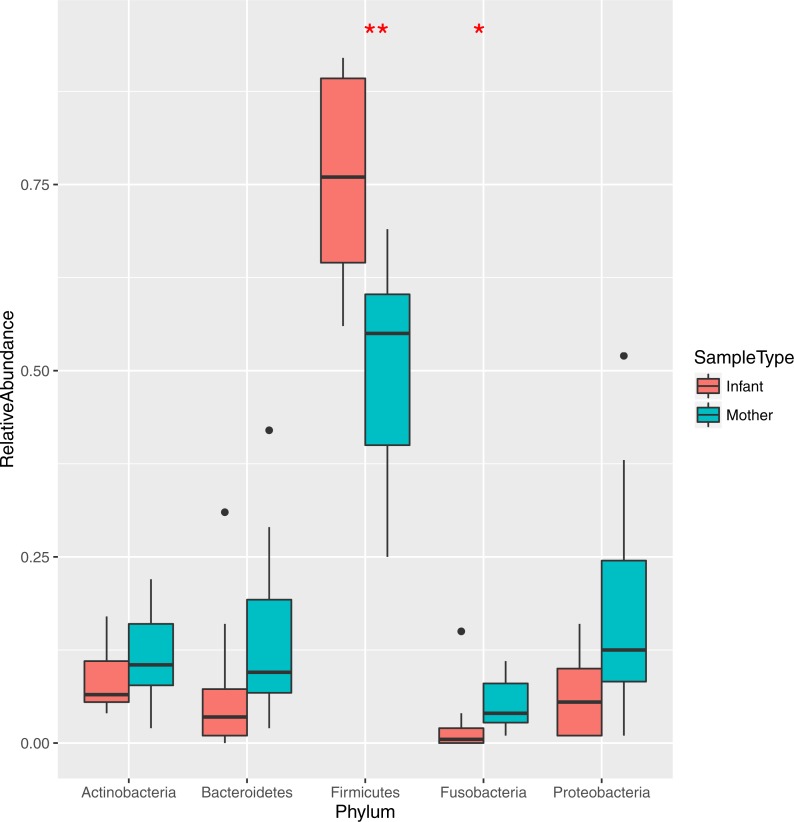
Relative abundance of the major bacterial phyla in mother and infant saliva samples.Differences between groups of mother and infants for phyla Firmicutes and Fusobacteria are significant (∗∗p < 0.01, ∗p < 0.05).